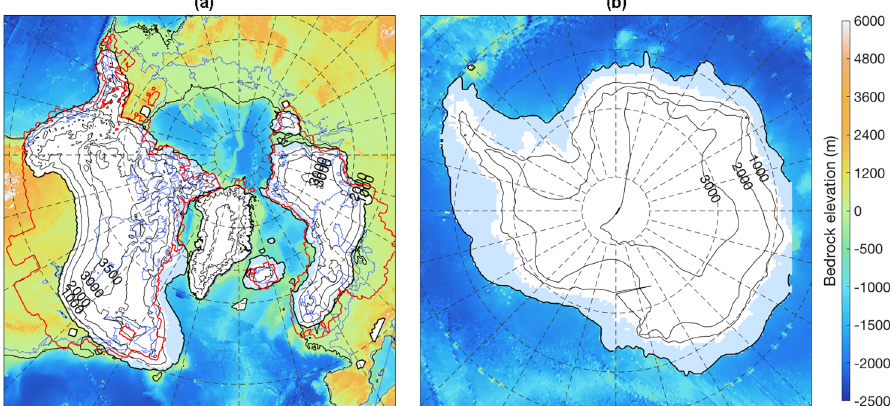
Figure 8. Ice sheets (white) and shelves (light blue) at the LGM over (a) the Northern Hemisphere and (b) Antarctica, as simulated with the new model set-up. Contour lines for the Northern Hemisphere show ice thickness, and contour lines for Antarctica show surface elevation. Bedrock elevation not covered by ice is shown by colours, with present-day shorelines shown in blue and the ICE-5G ice margin shown in